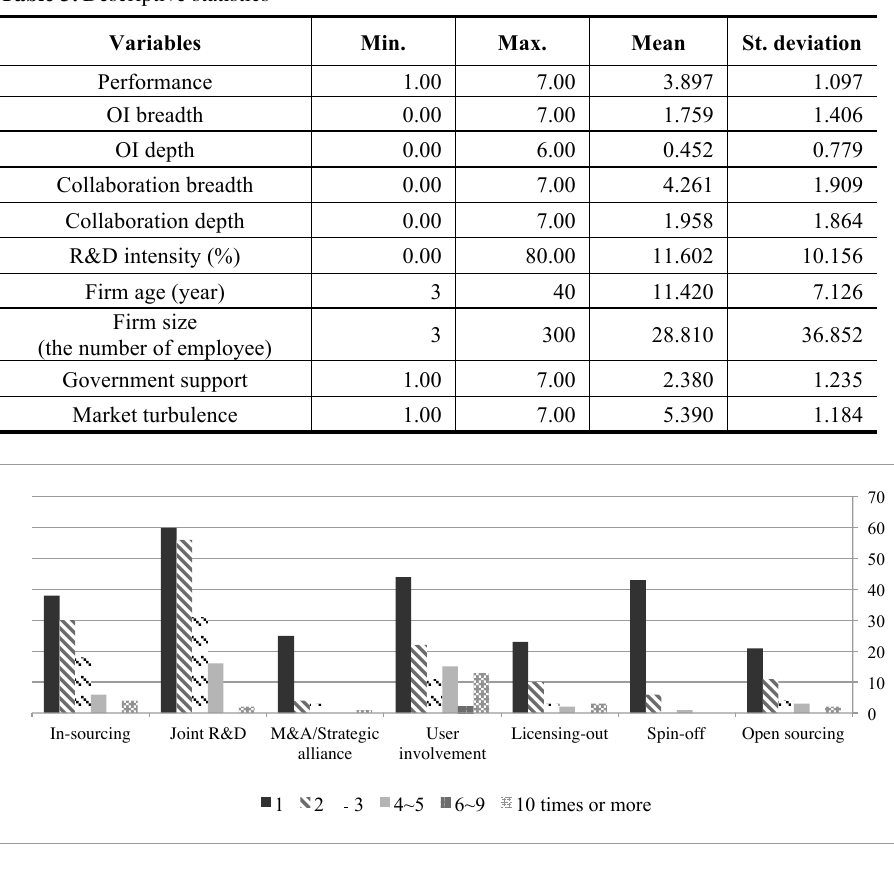
Fig. 4. Open innovation adoption (Unit of the vertical axis: the number of